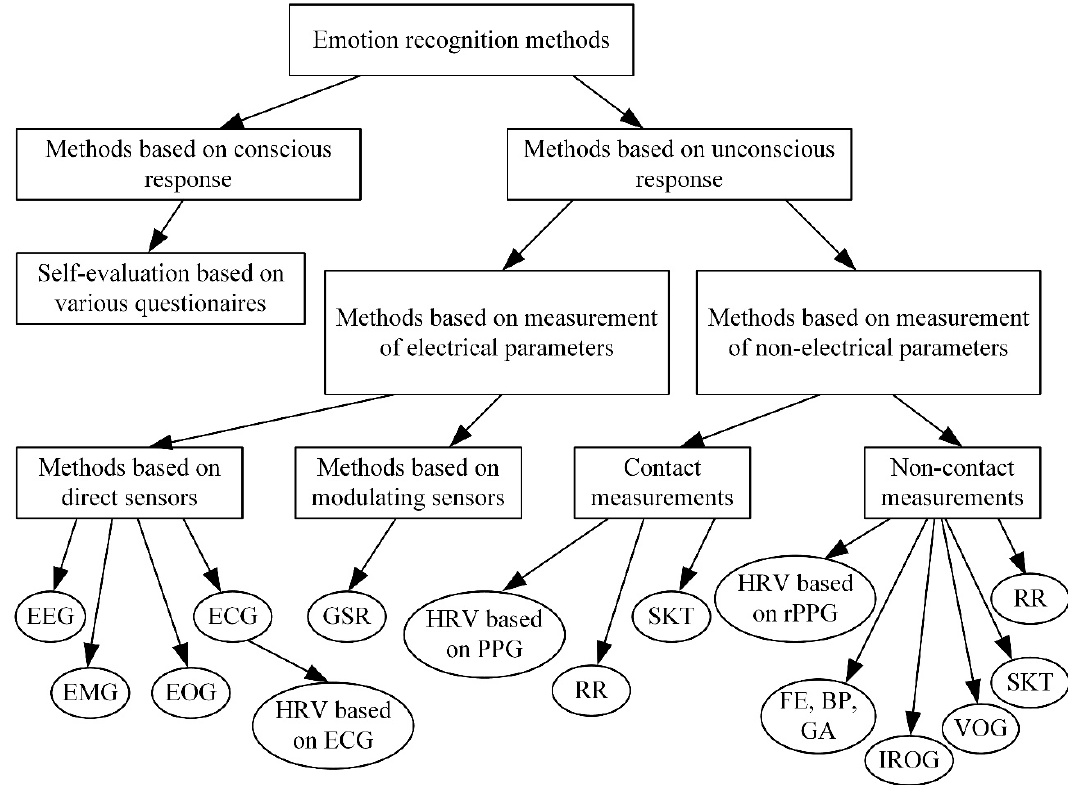
Figure 15. Classification of measurement methods for emotions recognition.